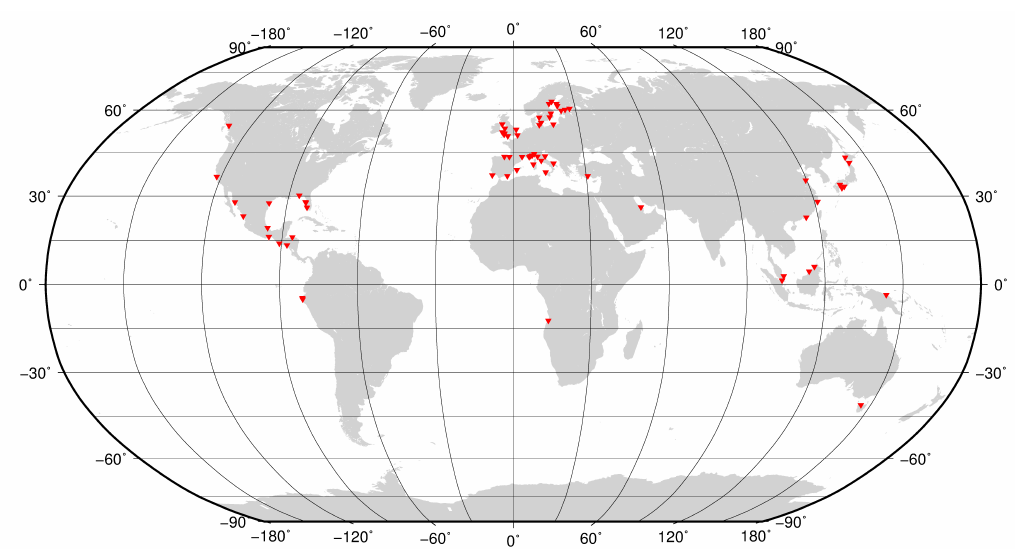
Figure 1. Location of the in situ data used in this